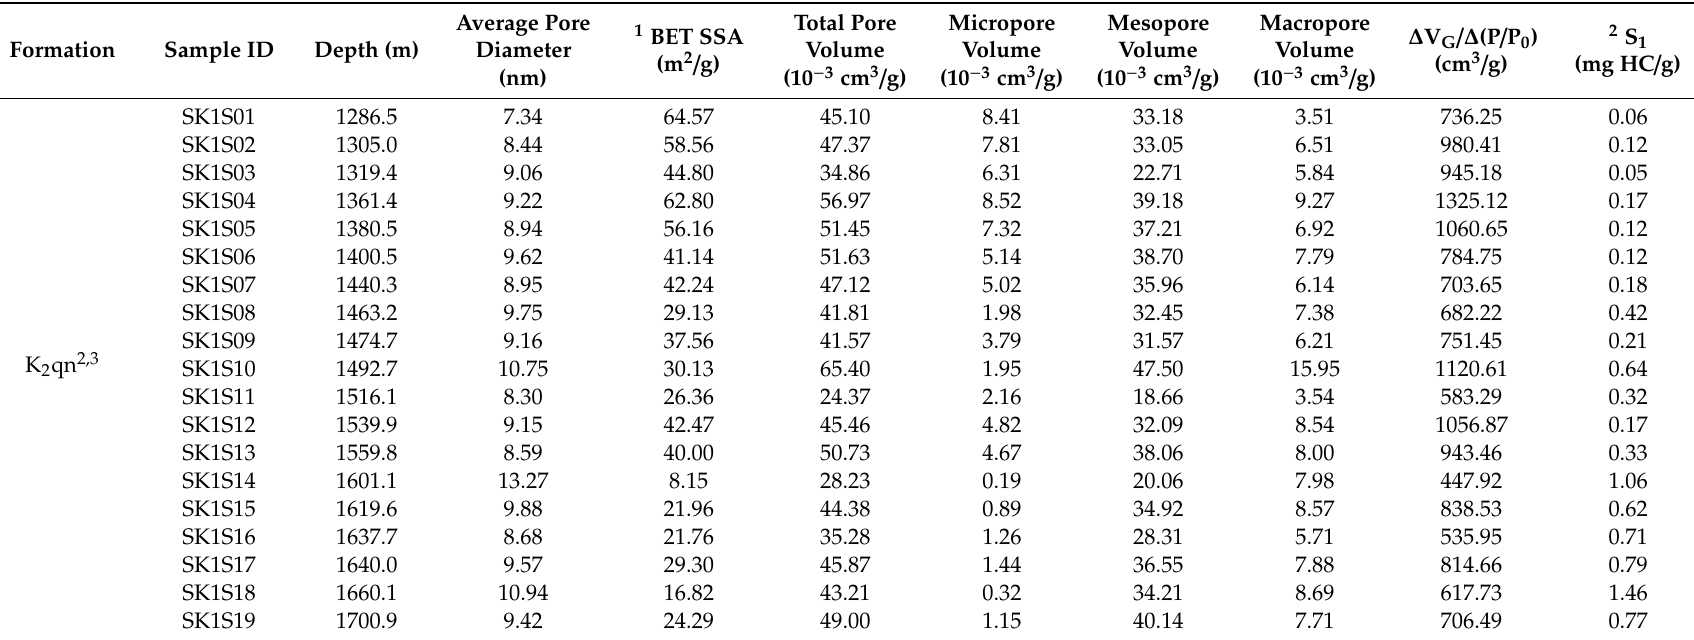
Table A1. Quantitative pore parameters from low-pressure nitrogen adsorption analyses and free hydrocarbon